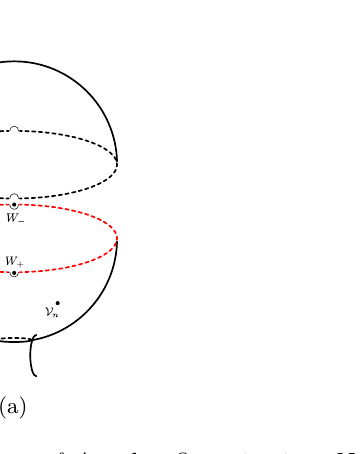
Figure 9 . The Contour of Angular Quantization . Near any pair of W + , W − insertions on the worldsheet of a linear-dilaton × S 1 string diagram, one may slice their neighborhood as shown on the left. The upper cap prepares a pair of folded strings in the TFD state of angular quantization, which is glued to the rest of the worldsheet below. In computing a string amplitude of linear-dilaton × time including Euclidean time winding insertions, one must choose a deformed contour of integration in evaluating the sum over moduli. On the right is sketched the contour used to evaluate the integral of a Lorentzian scattering operator. When the integrated insertion approaches another ordinary operator, the contour is deformed along the Lorentzian cylinder of radial quantization according to the prescription of [38]. When it approaches a winding operator, the Euclidean cap that prepared the TFD state of folded strings is replaced by the pair of Rindler diamonds shown and glued along the red zero-time slice. The radial deformation prevents two scattering insertions from colliding, while the angular deformation prohibits a scattering operator from looping around a winding